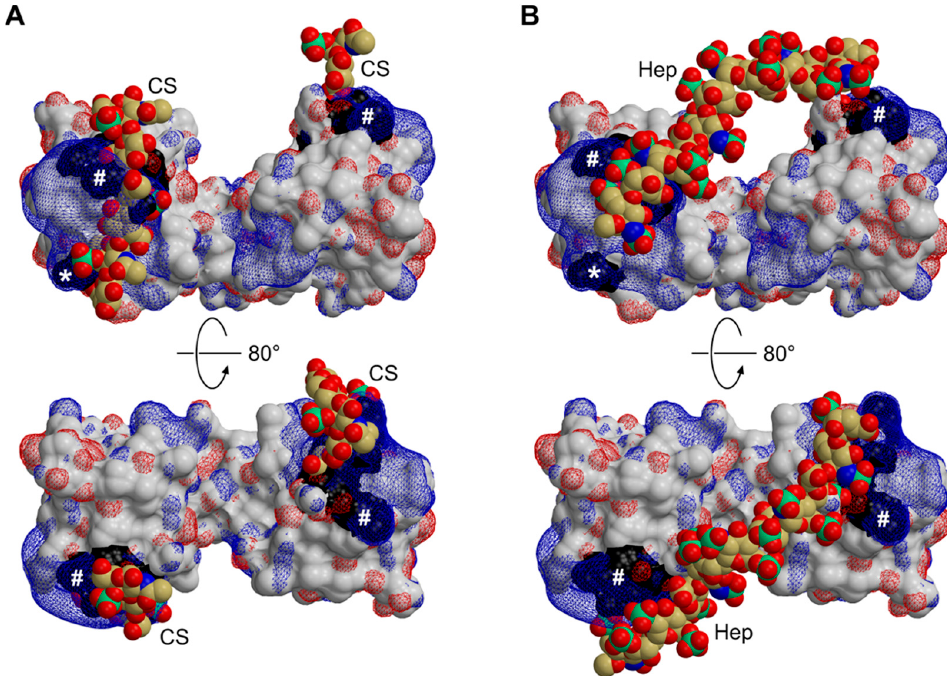
Figure 5. Potential GAG interaction modes of CCL16. The crystal structure of CCL16 (surface representation, oriented as in Figure 4A) is shown in the context of two published models featuring short mucopolysaccharide chains docked to CCL5. The chondroitin sulfate (CS, panel A ) and heparin (Hep, panel B ) moieties are drawn in space-filling mode; black patches on the CCL16 surface indicate basic residues K47, R48, and R50 of the BBxB motif (#) as well as K21 (*), suggested to mediate this interaction by analogy to CCL5. The electrostatic potential of CCL16 is contoured at +3 kT/e (blue) and − 3 kT/e (red).